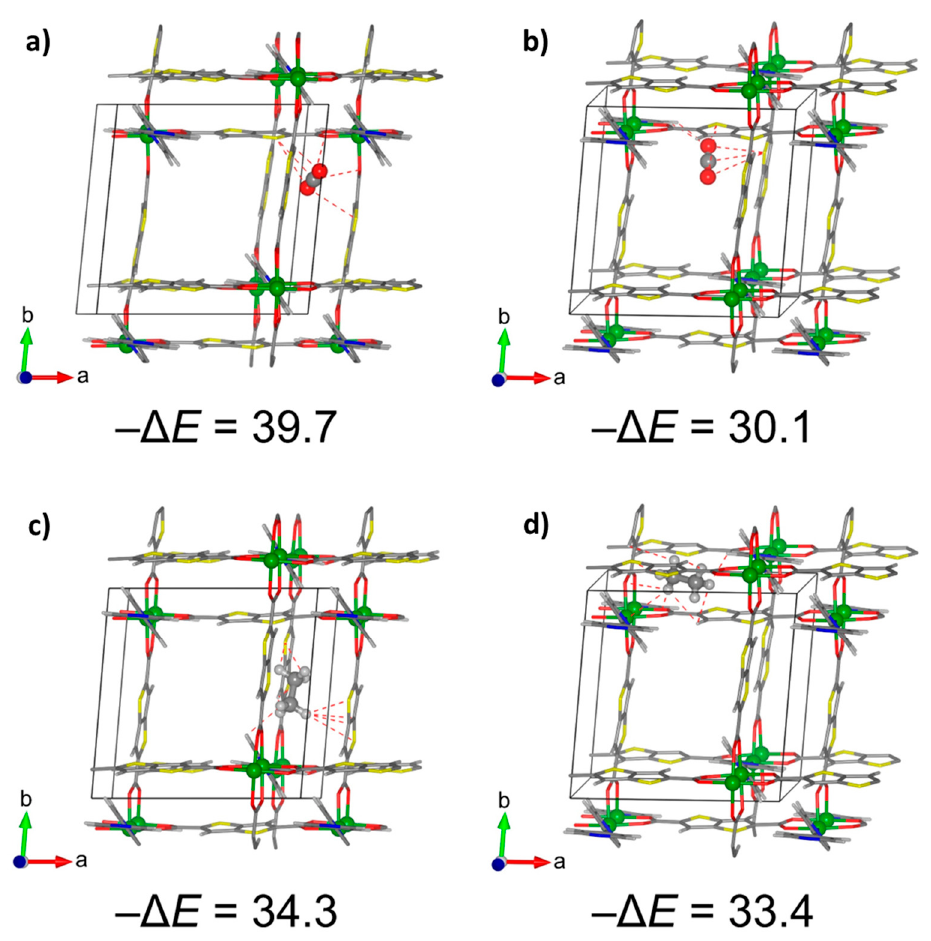
Figure 4. Calculated structures and adsorption energies ( ∆ E , kJ · mol –1 ) of CO 2 ( a , b ) and C 2 H 6 ( c , d ) molecules at the most relevant adsorption sites inside [Zn 2 (ttdc) 2 (bpy)] pores. Short host–guest interatomic contacts are indicated by red dashed lines (a single guest molecule is shown). Color code: Zn (green), S (yellow), O (red), N (blue), C (gray), H (light gray).